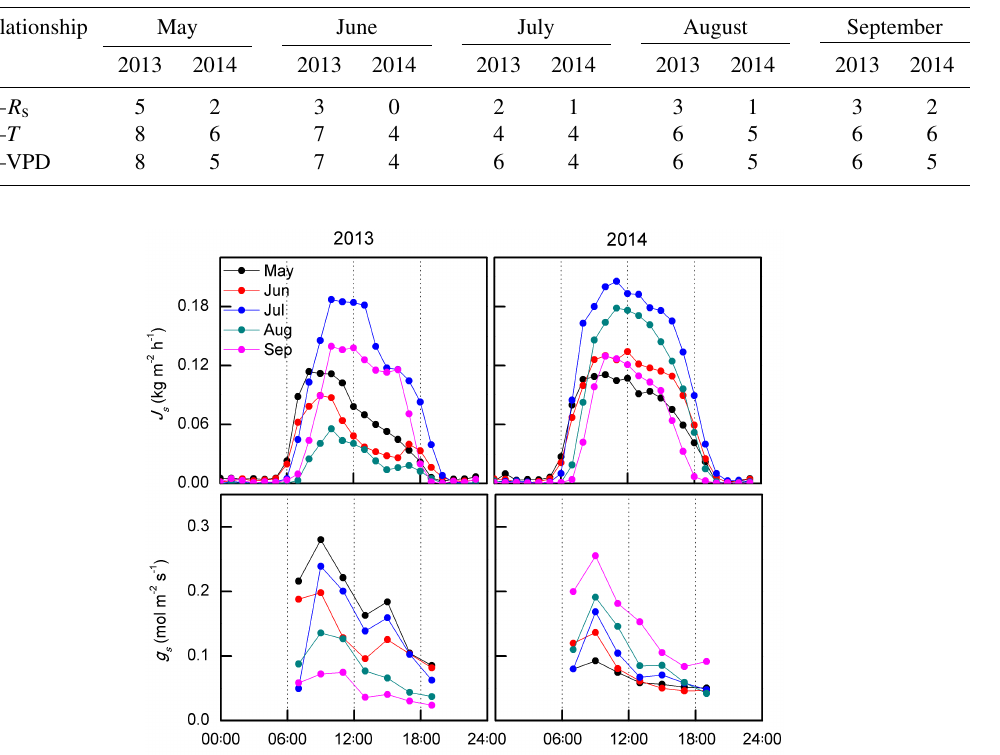
Table 2. Mean monthly diurnal cycles of sap flow ( J s ) response to shortwave radiation ( R s ), air temperature ( T ), and water vapor pressure deficit (VPD), including lag times (h) as a function of R s , T , and VPD.